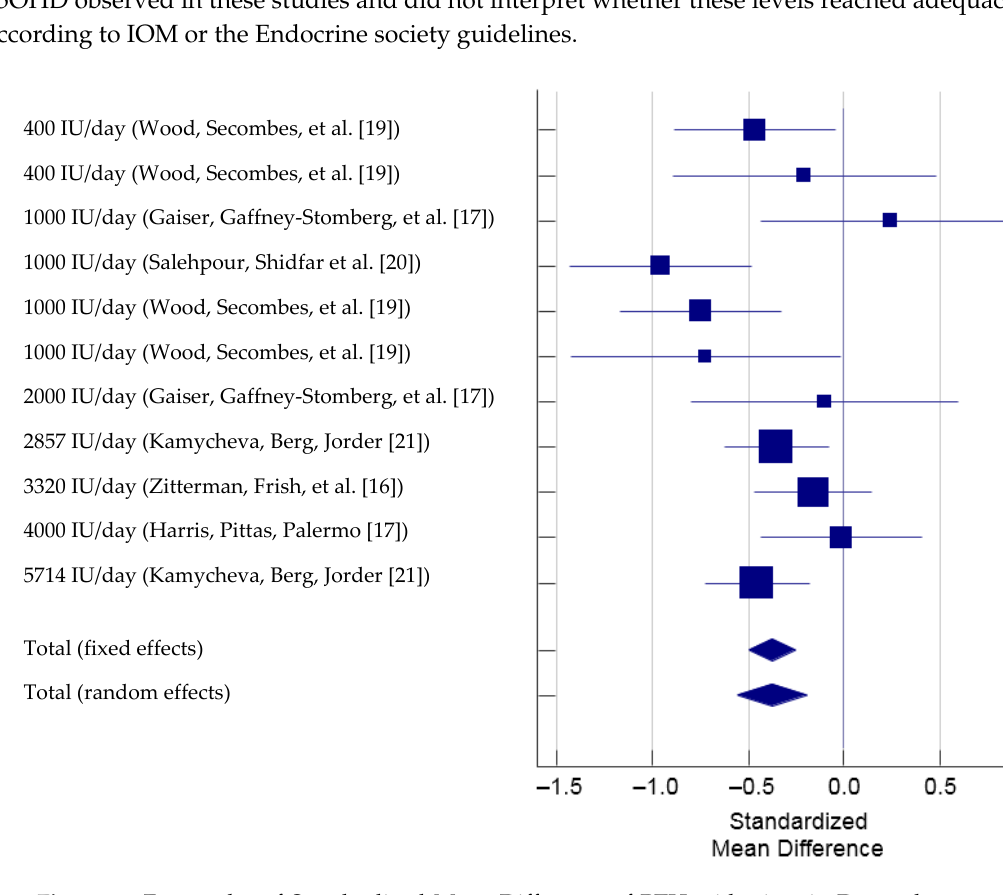
Figure 2. Forest plot of Standardized Mean Difference of PTH with vitamin D supplementation.